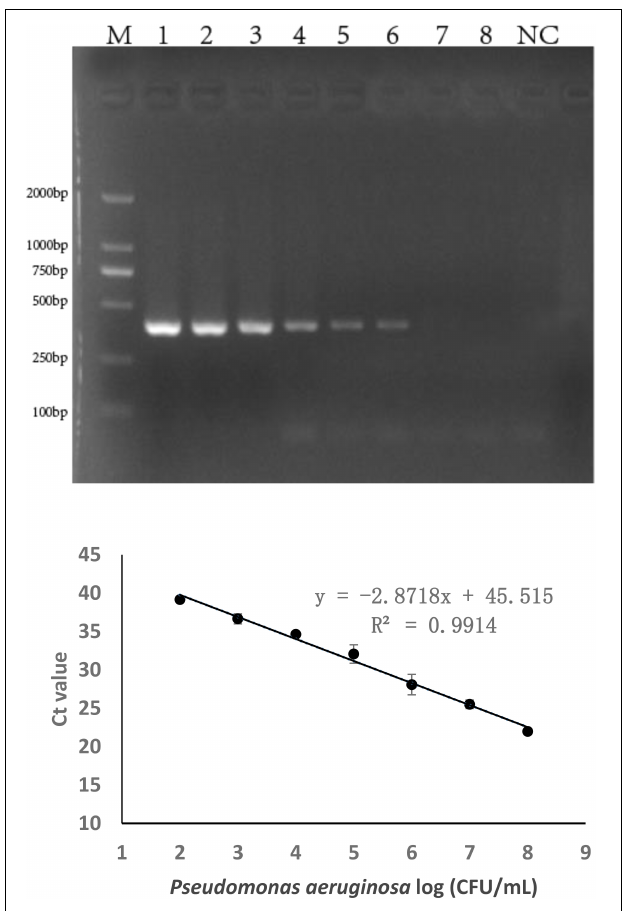
FIGURE 2 | PCR detection sensitivity using primers for P. aeruginosa serogroup G-specific genes. 2.1: Amplification using PA59_01276 primers. Lane M: DL DNA 2000 marker, lane NC: negative control, lanes 1–8: Ten-fold sample dilutions (4.0 × 10 8 CFU/mL to 4.0 × 10 1 CFU/mL). 2.2: Establishment of a standard curve for the detection of P. aeruginosa serogroup G. Plots of Ct values against the log numbers of P.